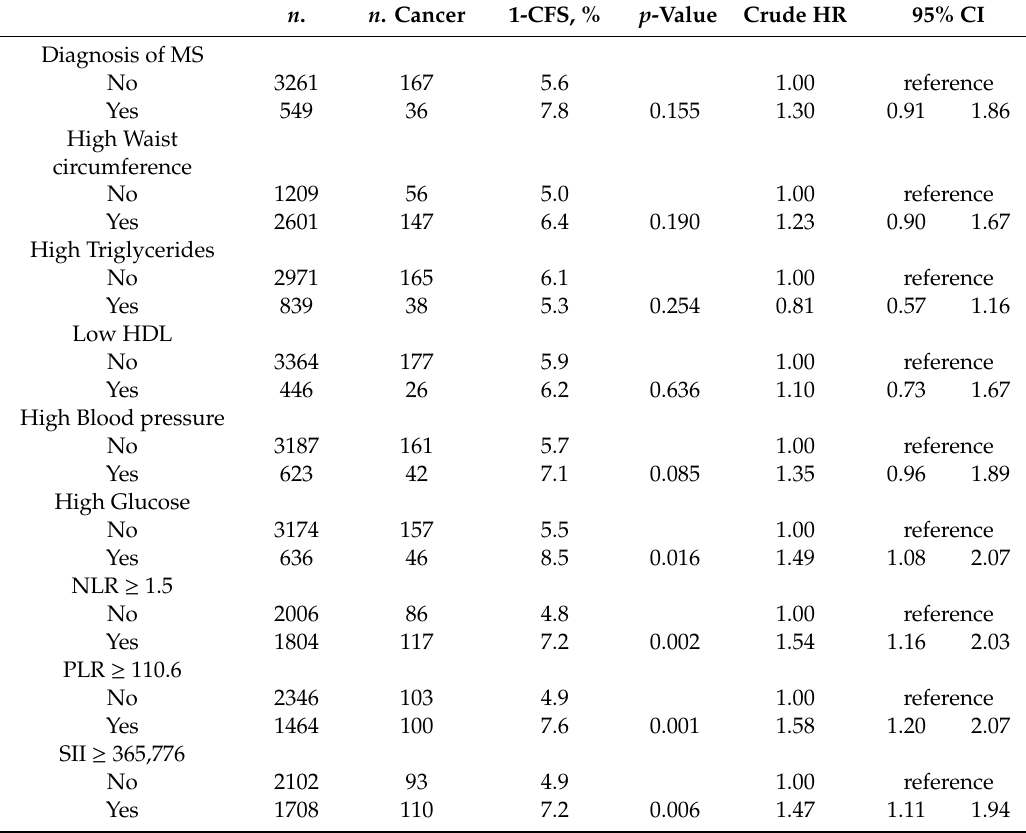
Table 2. Total number of subjects, and subjects diagnosed with cancer. n . n .